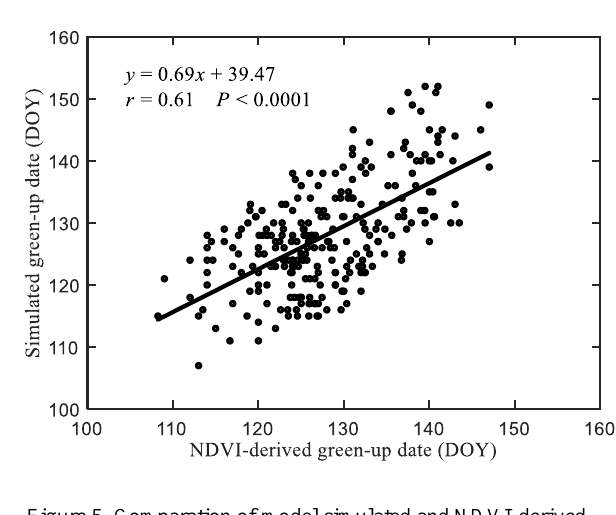
Figure 4. Comparation of model simulated and NDVI-derived green-up dates: internal validation